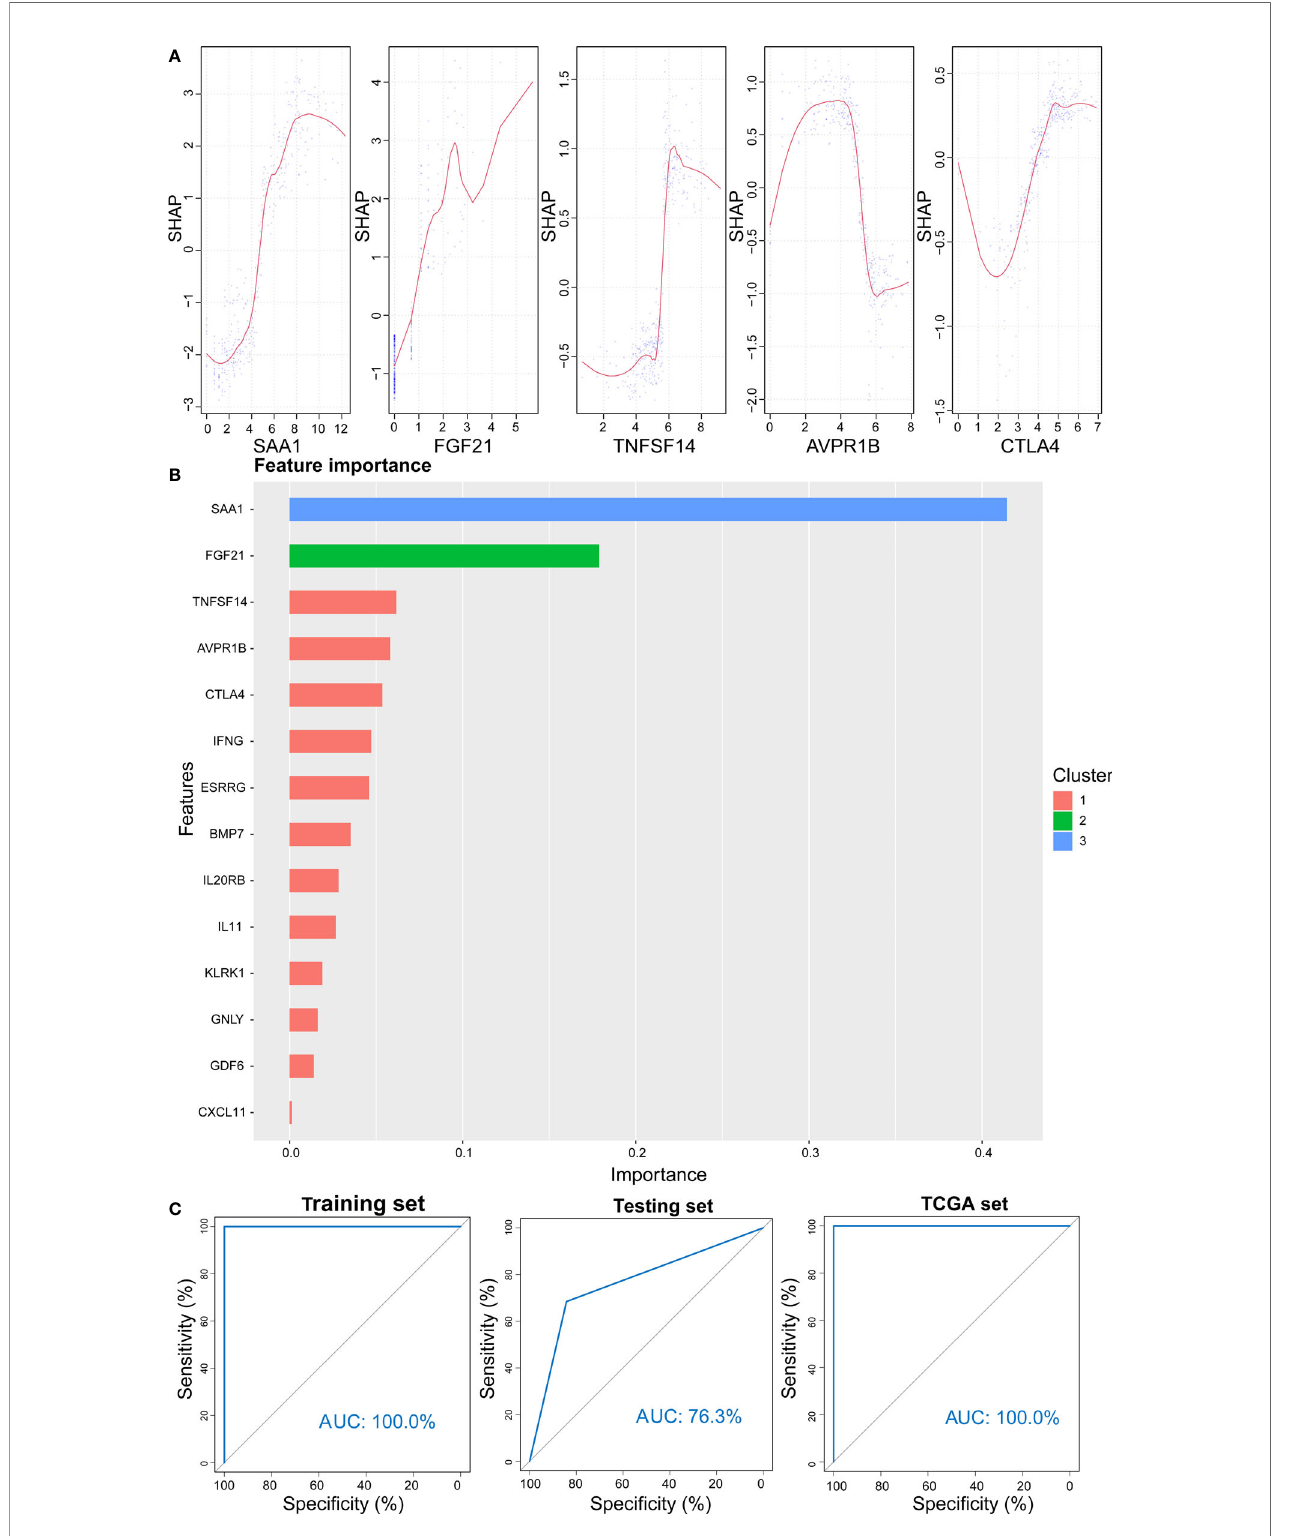
FIGURE 13 | Prediction results from the XGBoost algorithm. (A) SHAP contribution dependency plots for the training cohort. (B) Importance of 14 features of the training cohort. (C) ROC curve for XGBoost algorithm for the prediction of high- and low-risk patients in training, testing, and entire